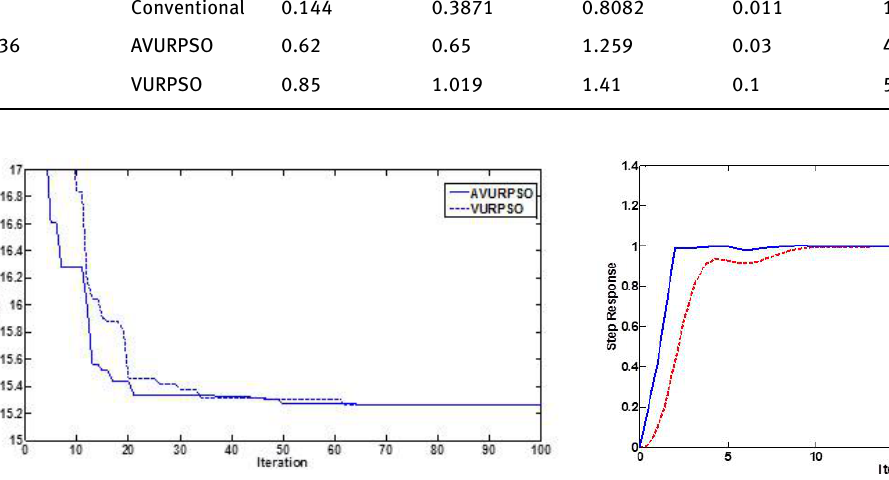
Figure 3: Comparing the VURPSO and AVURPSO on speed of conver- gence in Example 1.